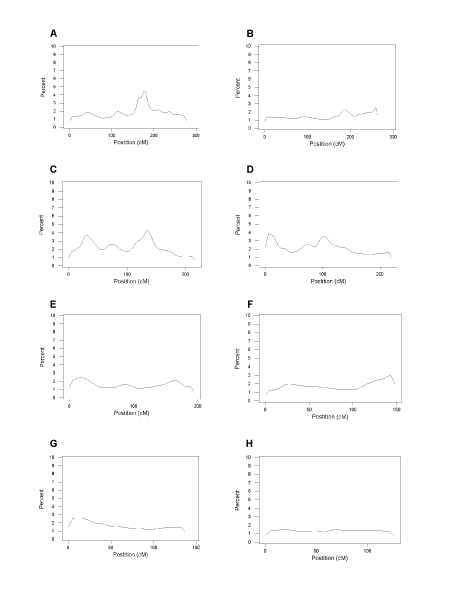
Chromosome PPLs. A, chromosome 1; B, chromosome 2;C, chromosome 3; D, chromosome 4; E, chromosome 5; F, chromosome 11;G, chromosome 14; H, chromosome 17